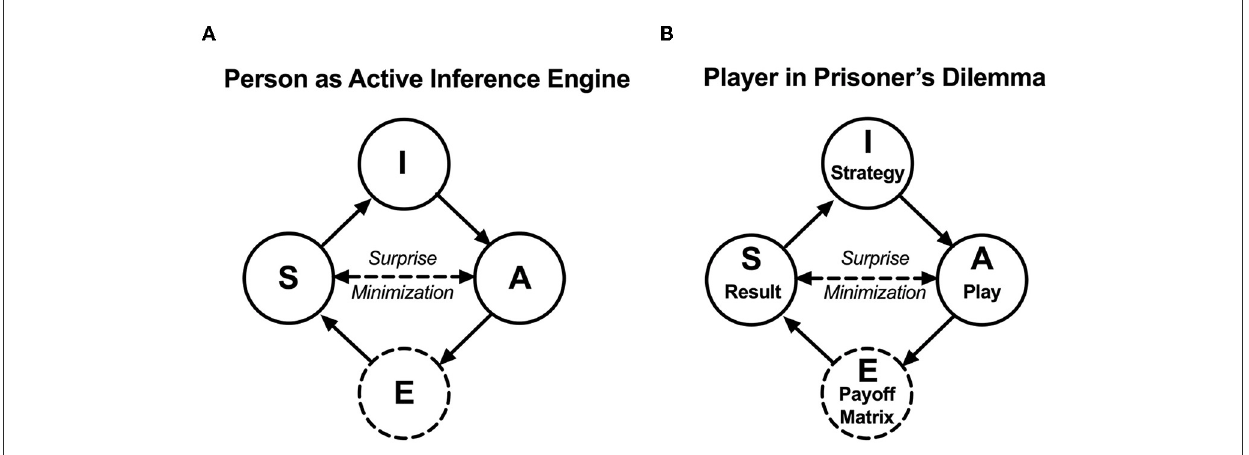
FIGURE3 (A) An active inference model and its environments: in an active inference model, an adaptive person functions as an active inference engine—consisting of nodes Active State (A), Sensory State (S), and Internal State (I) (solid circles)—interacting with external events in the environments, node External State (E) (dashed circle). In a hierarchical network, (E) represents events from environments at an external level, (S) represents the person’s afferent sensory state, and (A) represents the person’s efferent active state, both at a lower level, and (I) represents the person’s prior beliefs at a higher level. Nodes (E) and (I) do not have direct effects on one another, as they are separated by nodes (A) and (S). The double-arrowed line between (A) and (S) indicates the notion of active inference, that actions solicit a sensory outcome that informs approximate posterior beliefs in the internal states (I) about the external states (E). This is done by minimizing variational free energy—the upper bound of surprise of the active inference. (B) Applying the active inference model to reiterated prisoner’s dilemma, the nodes (E), (S), (A), and (I) can be equivalent to (Payoff Matrix of rPD), (Result, i.e., the readout of payoff in a trial), (Play of “cooperate” or “defect”), and (Strategy, e.g., Tit-for-Tat),